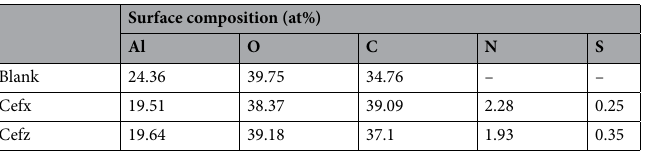
Table 6. XPS results of elemental composition (atomic percent) of Al in 0.1 M NaOH in the absence and presence of 300 ppm of Cefx and Cefz at 293 K.